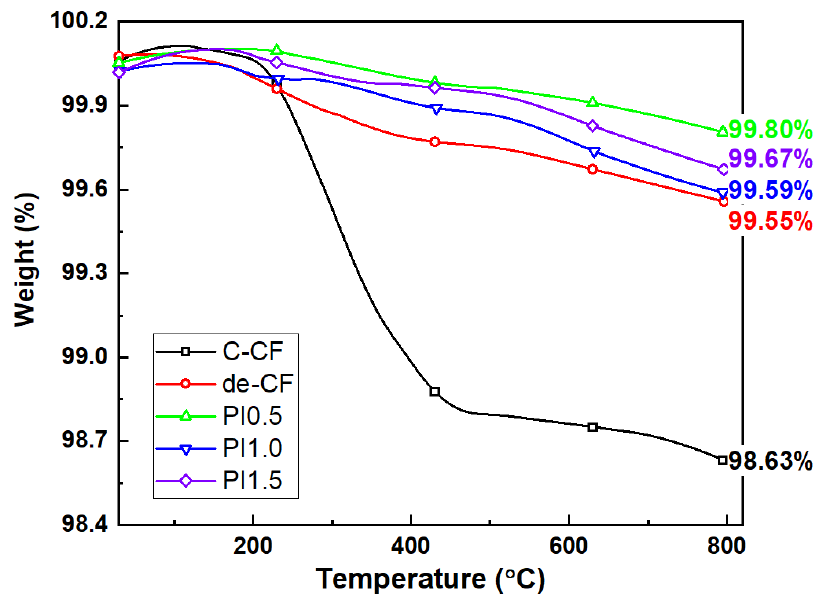
Figure 11. TGA curves of C−CFs, de−CFs, PI 0.5 wt%, PI 1.0 wt%, and PI 1.5 wt% sized CFs.